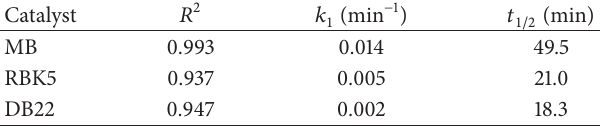
Table 1: Pseudo-first-order kinetic parameters of different dyes. Catalyst